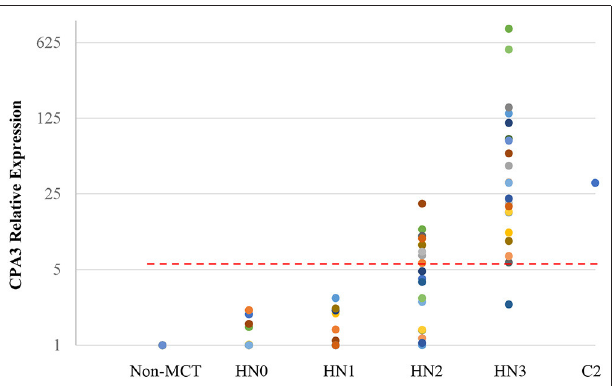
FIGURE 1 | Relative mRNA expression of CPA3 in each HN group determined by quantitative RT-PCR. Symbols showed mRNA levels in 17 LNs with HN0, 20 LNs with HN1, 20 LNs with HN2, and 21 LNs with HN3 compared with mixed HN0 LNs used as a calibrator. Red lines showed cut-off value at 5.79.